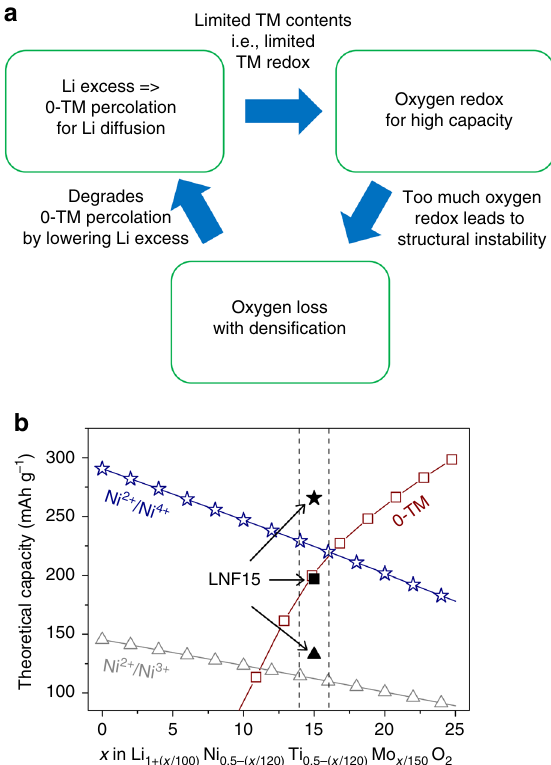
Fig. 1 Material design principles. a Relationship between Li excess, oxygen redox and oxygen loss. Oxygen loss needs to be prevented so as to ensure a percolating network of 0-TM (transition metal) channels allowing facile Li diffusion in Li-excess disordered materials 9 . b Theoretical capacity of Li 1.15 Ni 0.45 Ti 0.3 Mo 0.1 O 1.85 F 0.15 (LNF15) overlaid with that of a range of Li – Ni – Ti – Mo oxides. Three different capacities, computed under the assumption of various possible mechanisms, are plotted as a function of Li-excess level: Ni 2+ /Ni 4+ redox capacity (star), Ni 2+ /Ni 3+ redox capacity (triangle), and 0-TM capacity (square) that is de fi ned as the Li capacity accessible through a percolating 0-TM network in the disordered rocksalt structure 4, 5 . Black symbols correspond to the fl uorinated